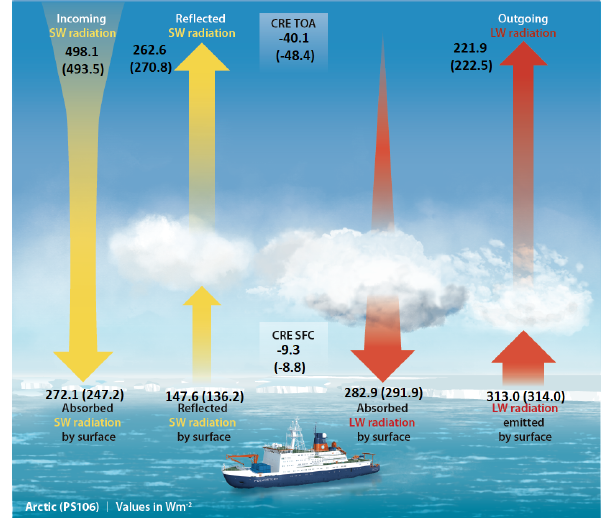
Figure 15. Radiation budget for the period of the PS106 cruise. Val- ues show mean values for the Arctic (70 to 90 ◦ N; top) and PS106 expedition (bottom in parentheses). Shortwave (SW) and longwave (LW) in yellow and red, respectively. Values in central boxes indi- cate the mean cloud radiative effect (CRE) at the surface (SFC) and the top of the atmosphere (TOA). Period analyzed is from 16:45Z on 28 May until 00:00Z on 20 June 2017 and from 22 June to 16 July 2017. Average values are given inWm − 2 .